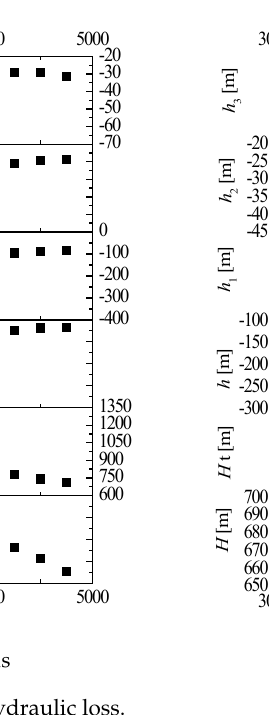
Figure 5. Energy conversion relationship in the main feedwater pump.